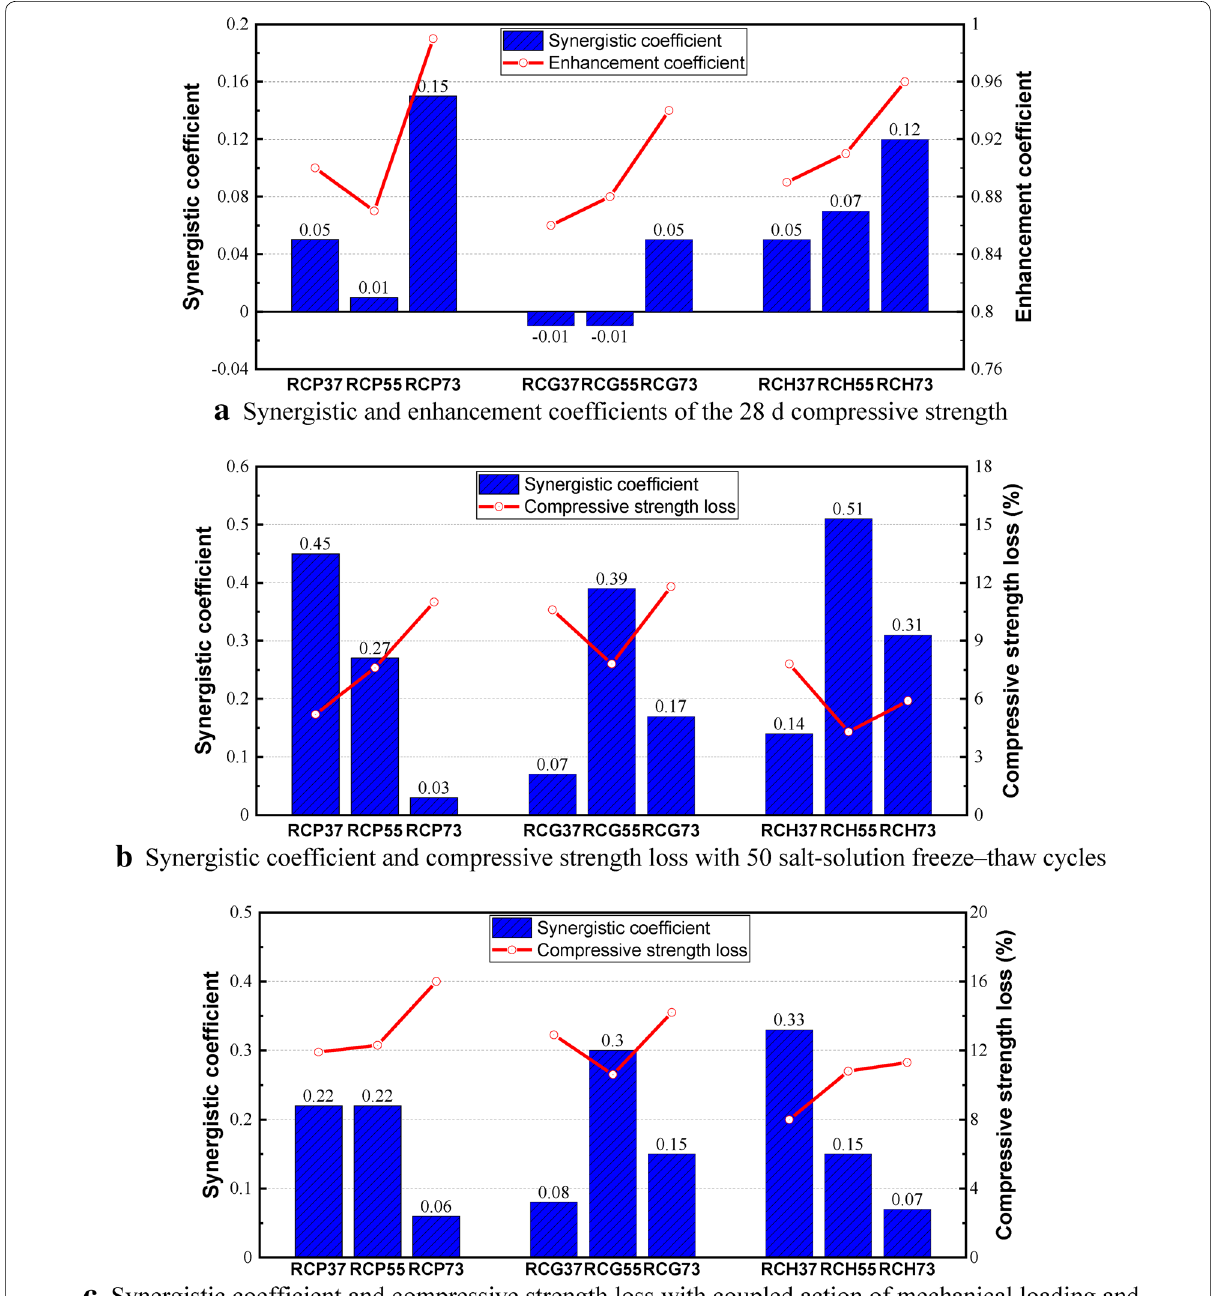
Fig. 9 Synergistic coefficients for the compressive strength and durability of RAC: a synergistic and enhancement coefficients of the 28-day compressive strength, b synergistic coefficient and compressive strength loss with 50 salt-solution freeze–thaw cycles, and c synergistic coefficient and compressive strength loss with coupled action of mechanical loading and salt-solution freeze–thaw